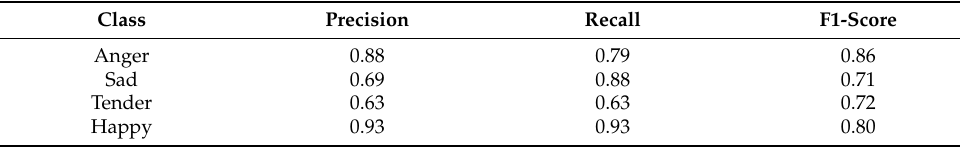
Table 2. Precision, Recall and F-1 score (in